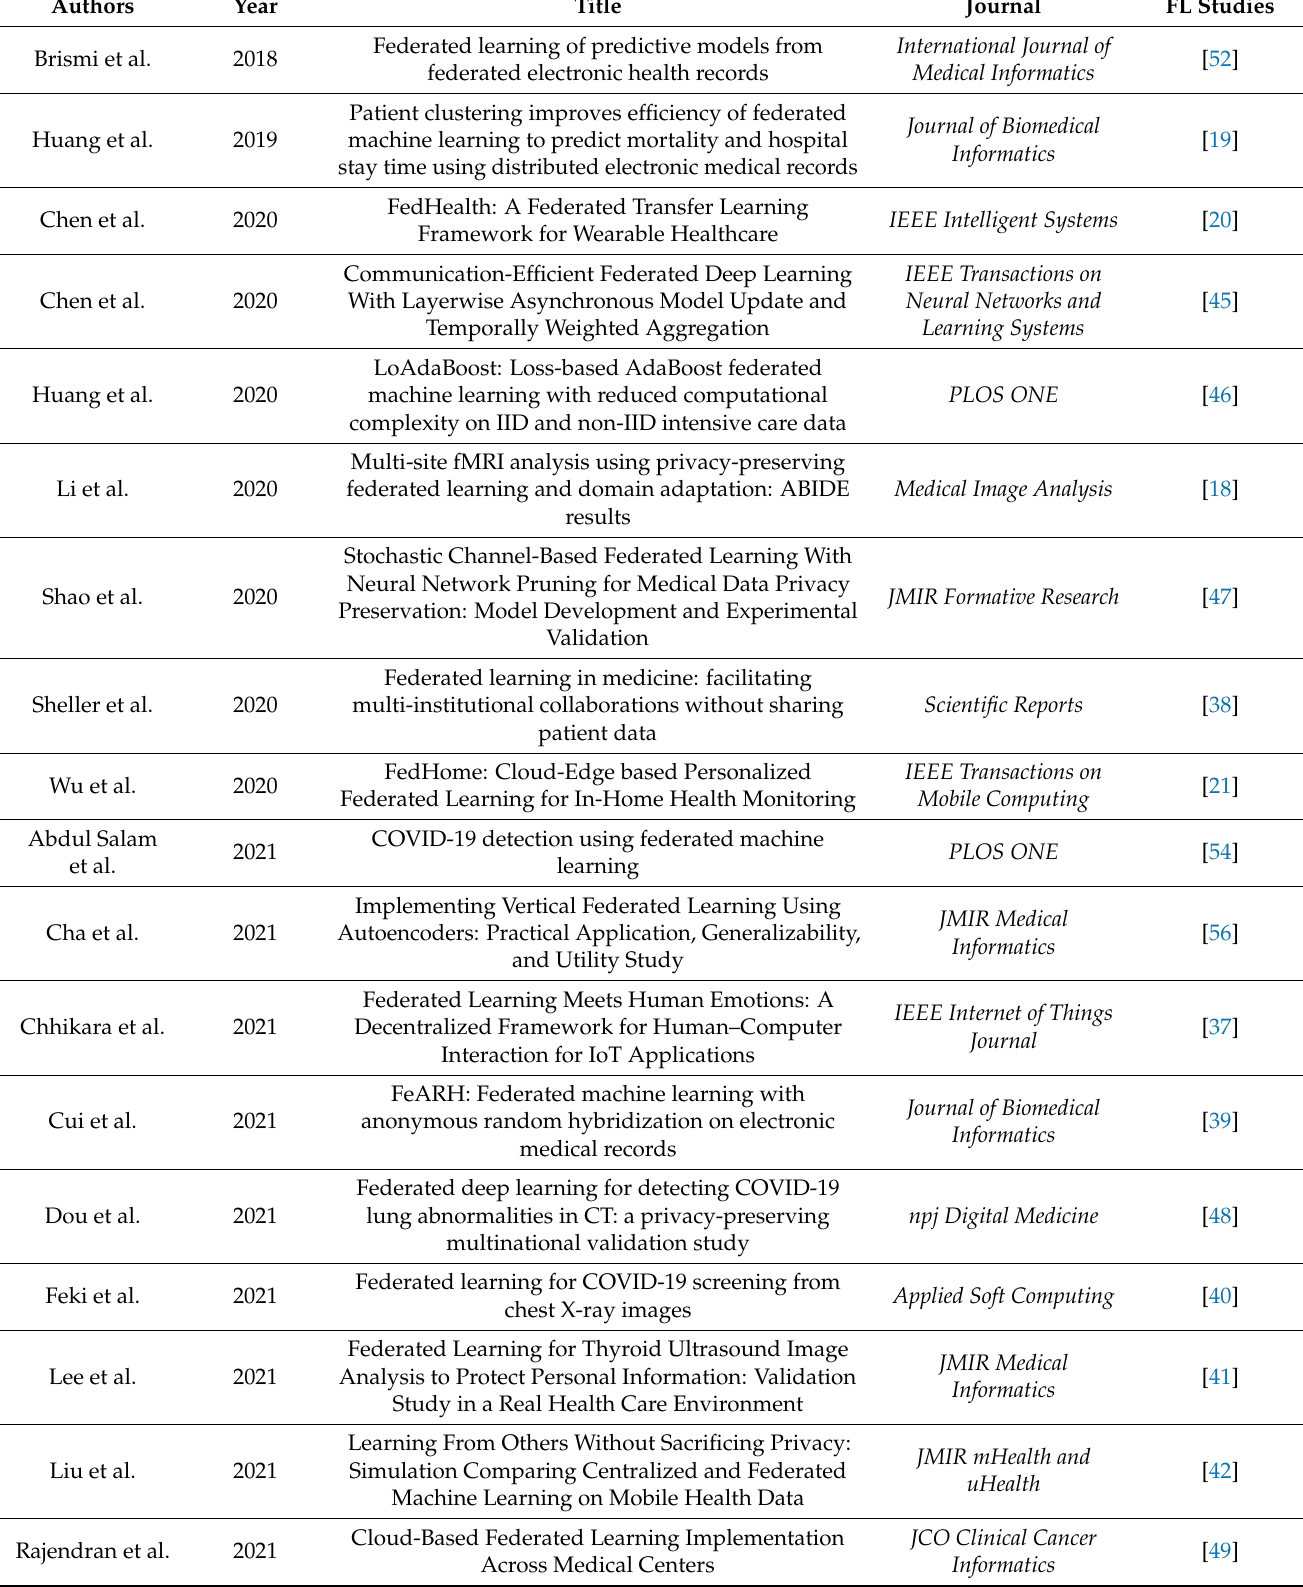
Table A2. Federated learning studies for medical